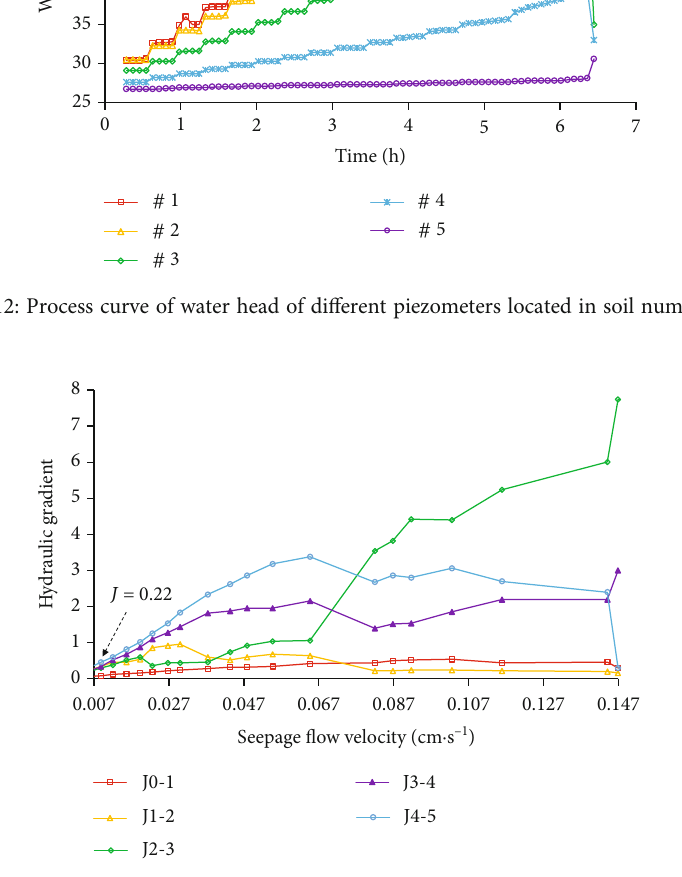
Figure 13: Process curve between hydraulic gradient and seepage fl ow velocity of di ff erent parts in soil numbered